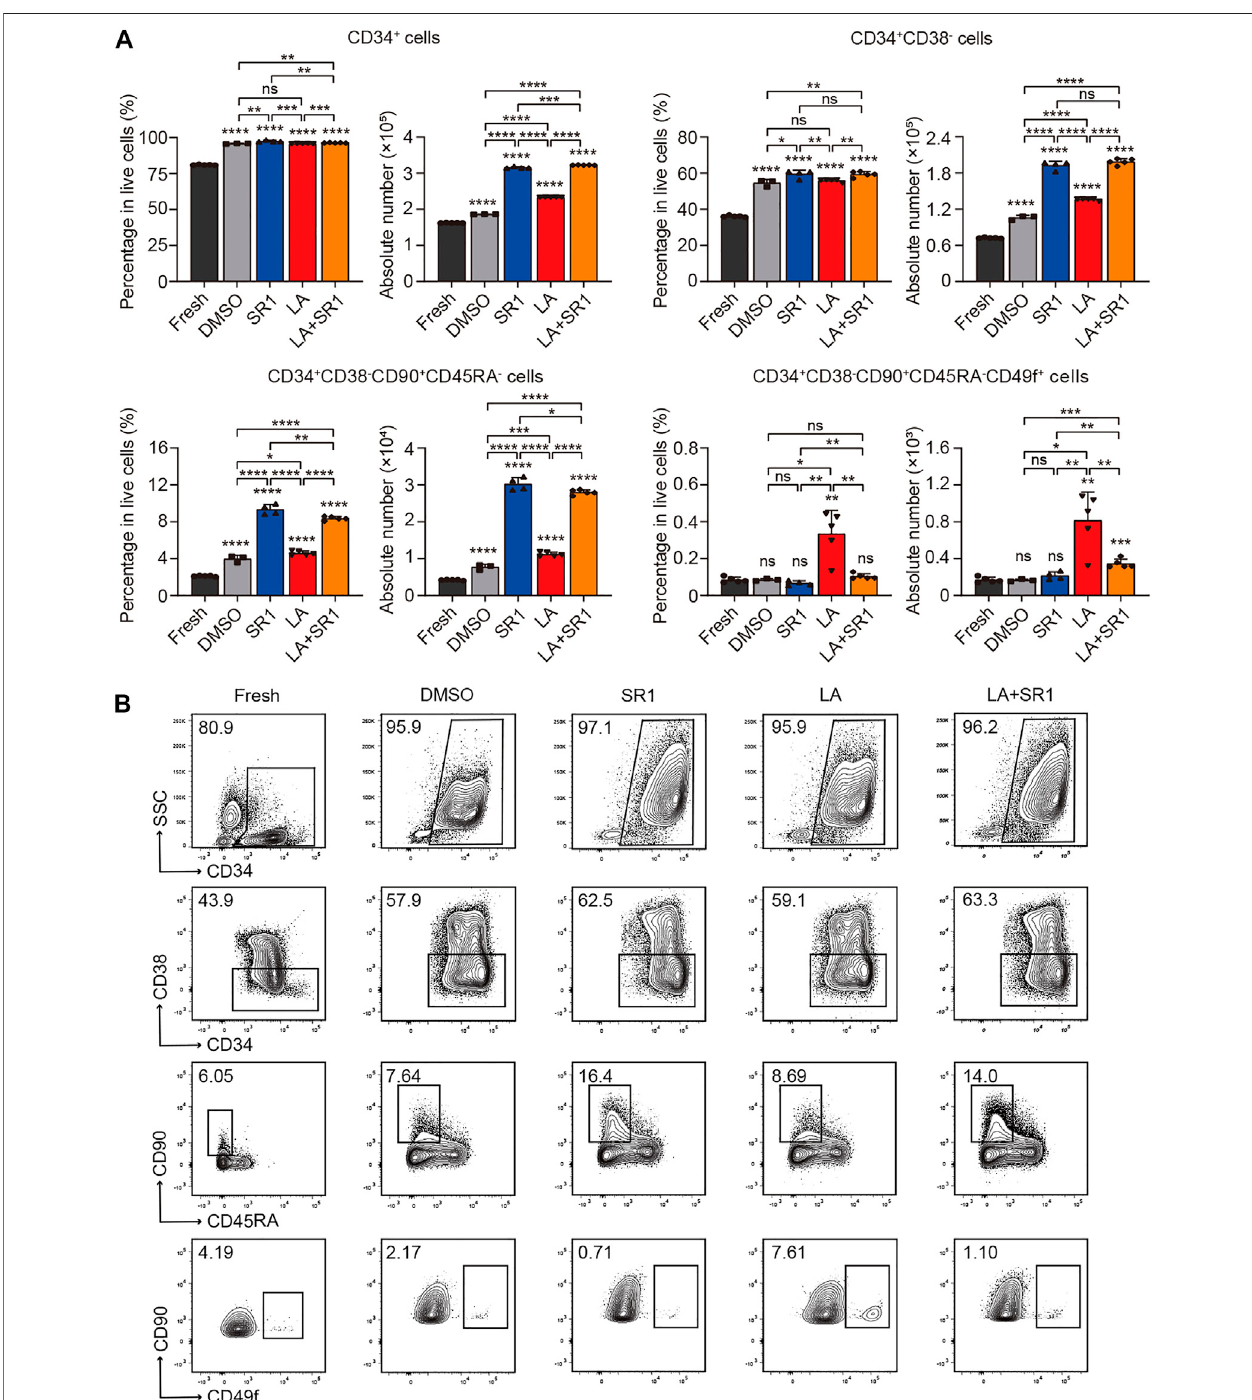
FIGURE 2 | LA promoted expansion of UCB HSCs in vitro . (A) The percentages in live cells and absolute number of CD34 + , CD34 + CD38 − , CD34 + CD38 − CD45RA − CD90 + and CD34 + CD38 − CD45RA − CD90 + CD49f + subpopulations before (fresh, n = 5) and after a serum-free 4 days culture with DMSO (0.05%, v/v)( n =3),SR1(1 µM)( n =4),LA(10 µM)( n =5), orLA+SR1( n =5).Alldatarepresentthemeans ±SD. Compared withfreshunless speci fi ed.* p < 0.05,** p < 0.01, *** p < 0.001, **** p < 0.0001 and ns = not signi fi cant by two-tailed unpaired Students ’ t -test. (B) Representative FACS pro fi les of phenotypically de fi ned subpopulations in cultured CD34 + cells as described in (A)